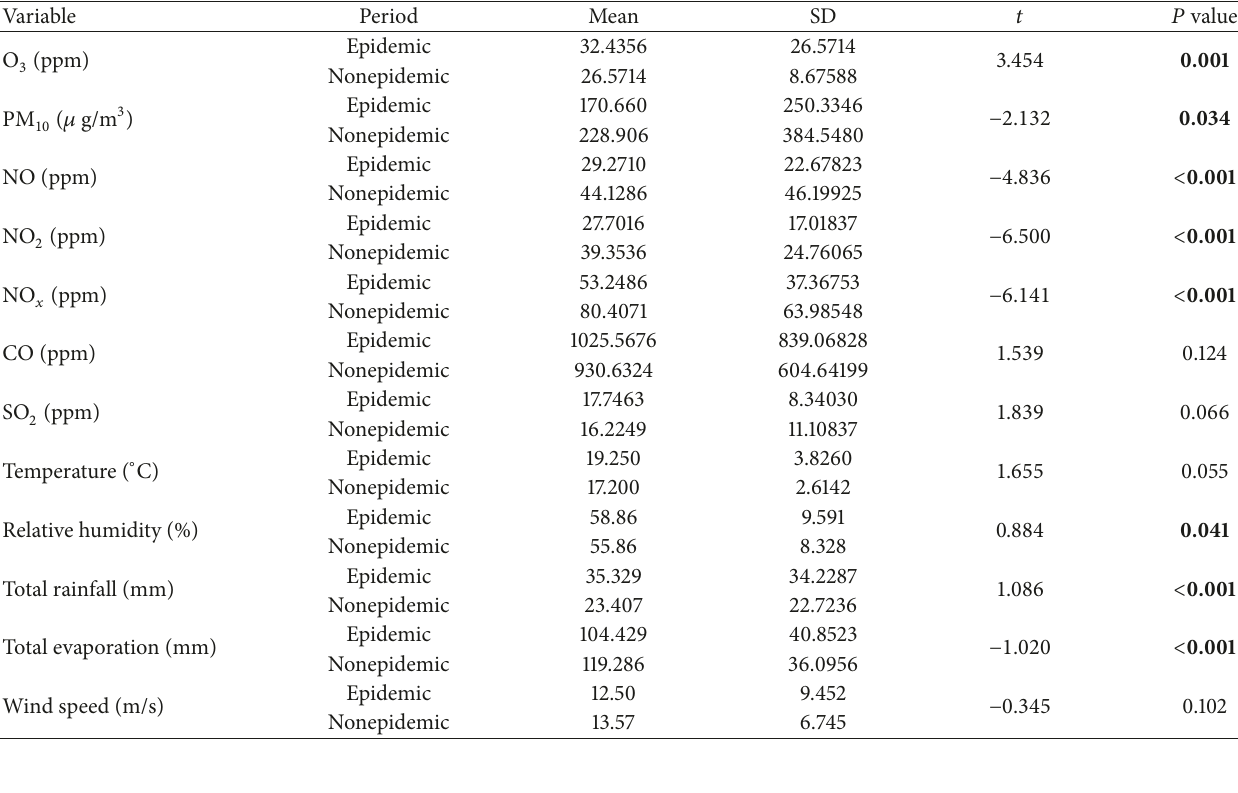
Table 2: Comparing the levels of air pollutants and climate factors during the epidemic and nonepidemic periods in Ahvaz from 2011 to 2015. Variable